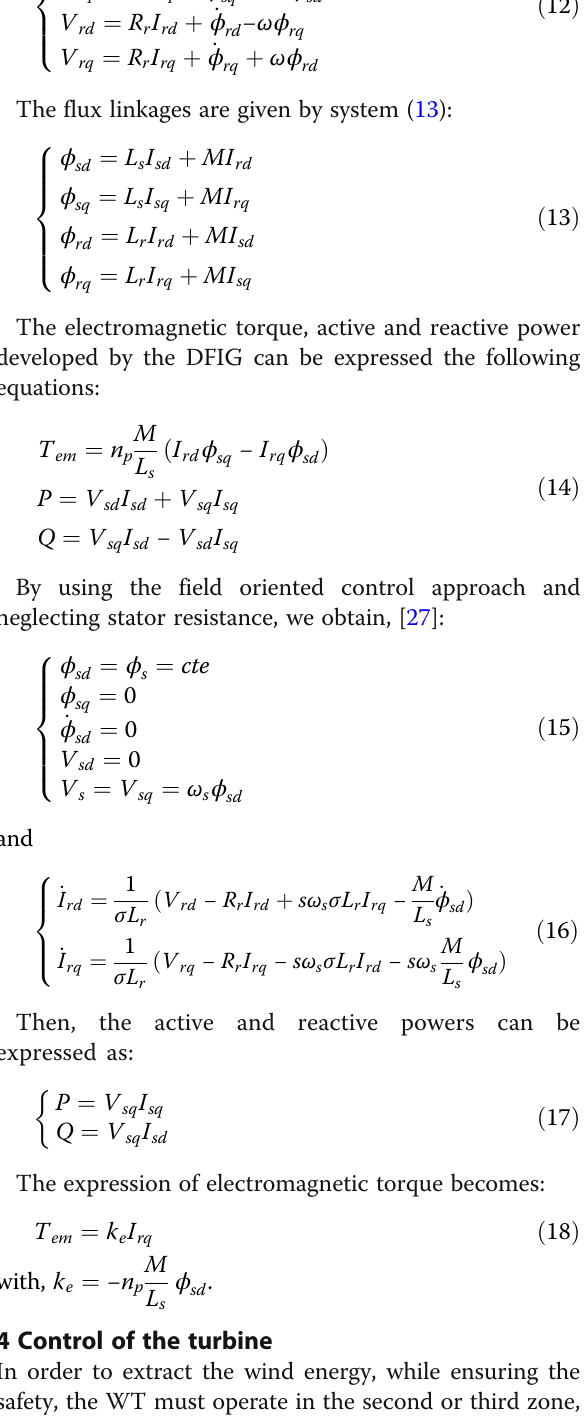
Fig. 4 Wind turbine control